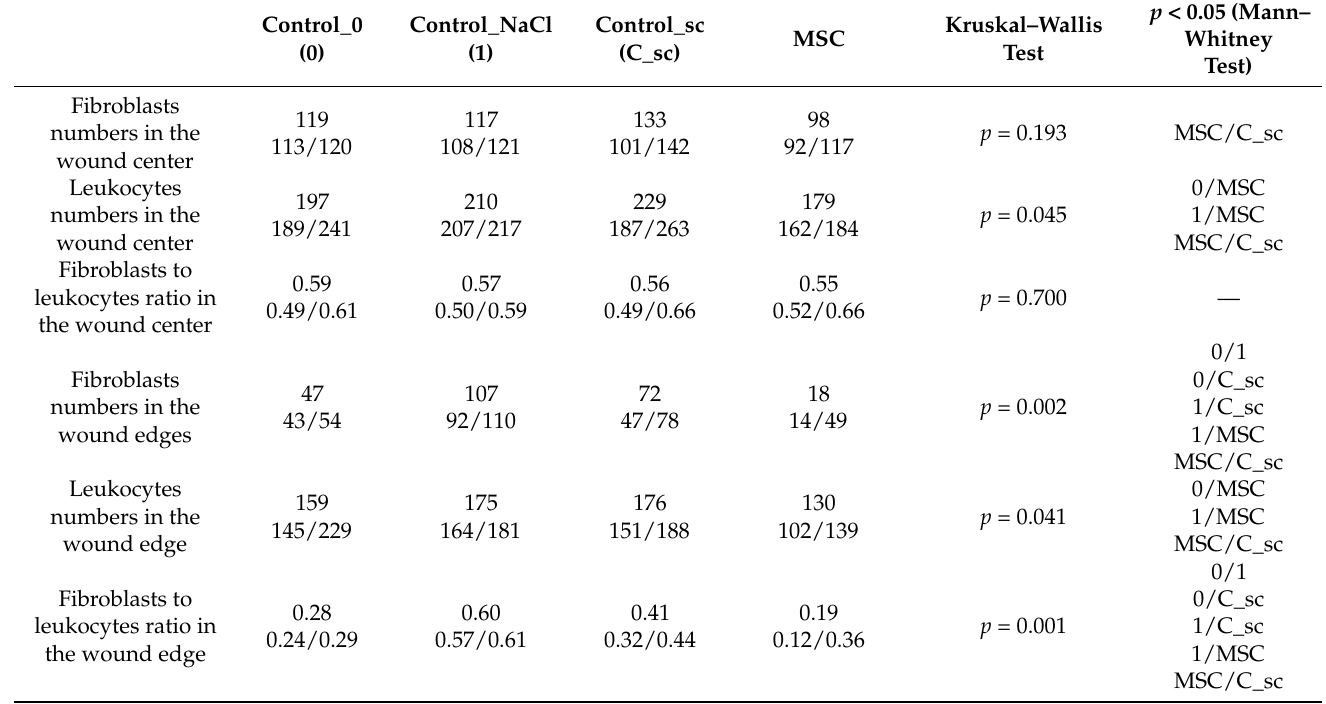
Table 1. Number of fibroblasts and leukocytes in the wound edges of the different groups on day 3